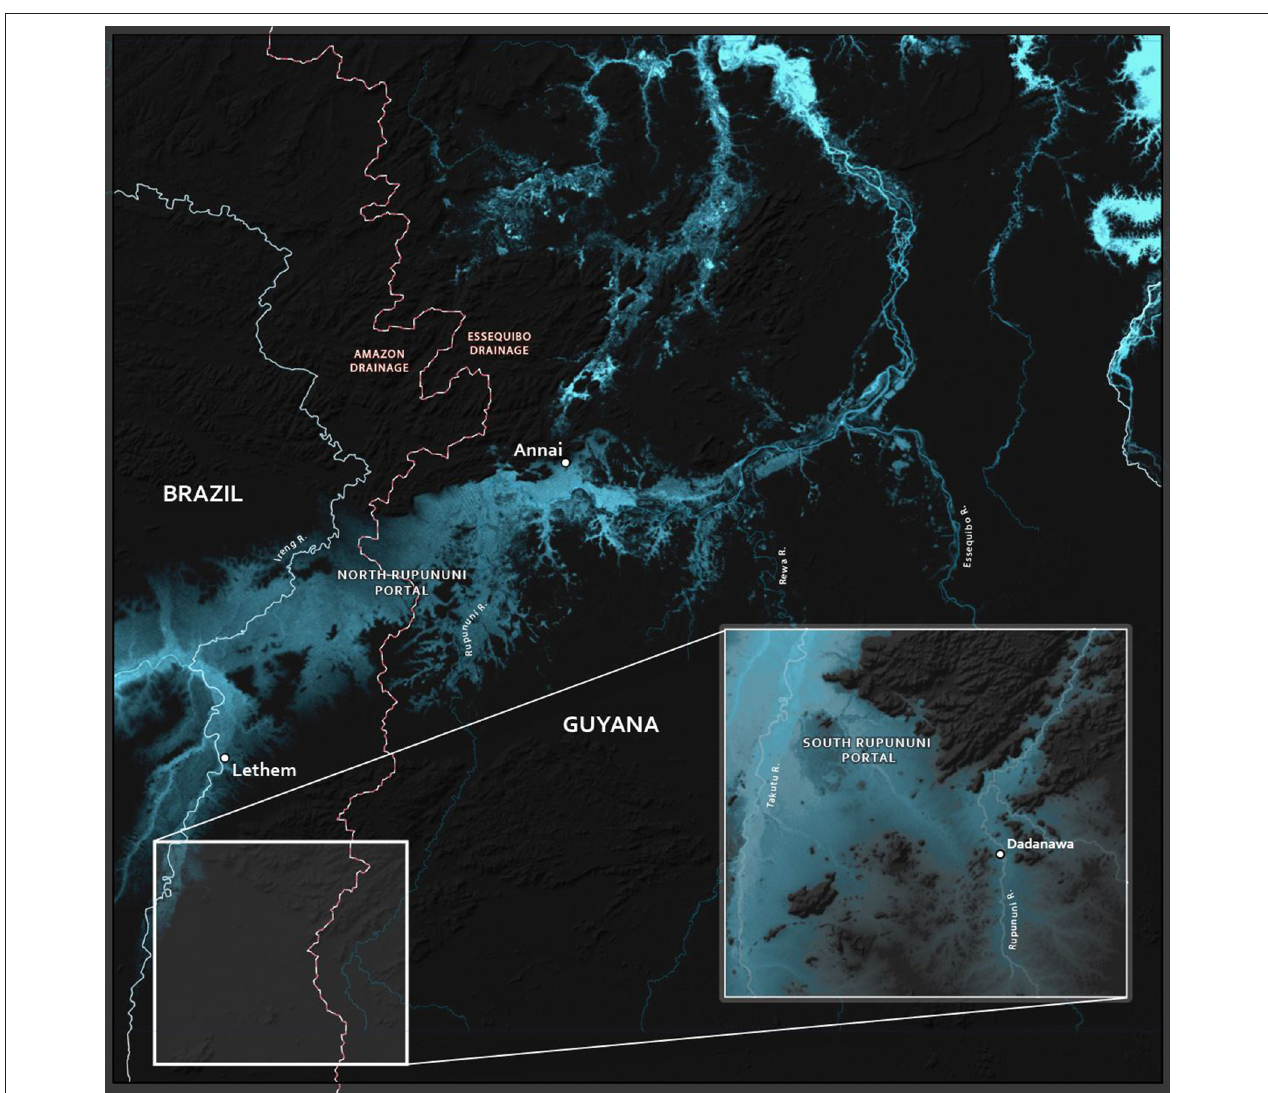
FIGURE 5 | Map of the hydrological portals in the North and South Rupununi. The red/back dashed lines indicate the divide between the drainages of the Amazon and Essequibo